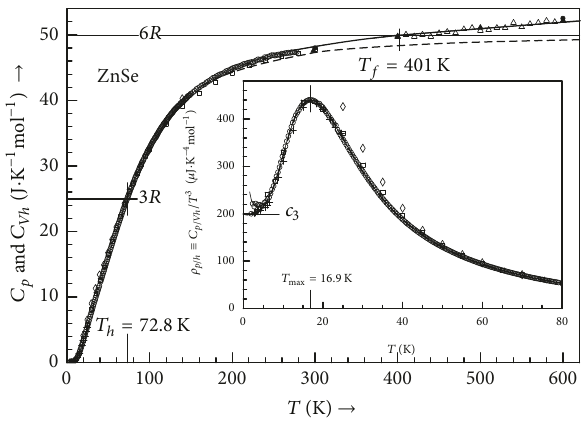
Figure 2: Fitting of the comprehensive set of 𝐶 low 𝑝 (𝑇) data ( I ) provided for ZnSe by Kremer et al. [46] in combination with a series of directly measured 𝐶 high 𝑝 (𝑇) values ( △ ) given for 400 K ≤ 𝑇 ≤ 600 K by Pashinkin and Malkova (Table 1 in [78]). For comparisons with other data available for ZnSe, we have also visualized the low- temperature data points given by Irwin and Lacombe [33] ( ◊ ), Birch [34] (+), and Sirota et al. [79] ( ◻ ), including the smoothed high- temperature data points quoted by Gadzhiev et al. [80] ( e ) and Pashinkin and Malkova [78] ( 󳵳 ) [ 𝐶 𝑝 (𝑇) curve (—; see (5)) and 𝐶 (𝑇) curve (––– ––; see (4), in combination with (9) and (14) to 𝑉ℎ (17)].